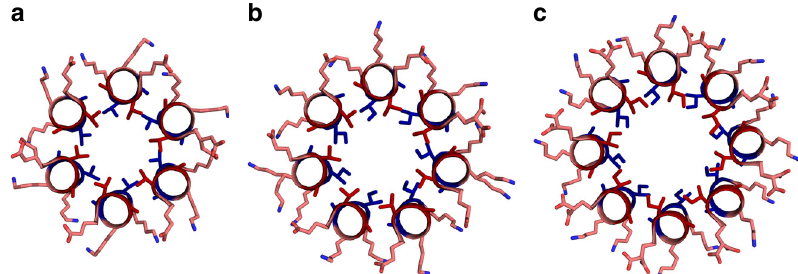
Fig. 5 α -Helical-barrel structures formed by the ββ class. a – c Single-heptad slices through structures for CC-Type2-VV ( a ), CC-Type2-IV ( b ), and CC- Type2-II ( c ). Val and Ile side chains are shown as sticks, and coloured blue and red to indicate perpendicular and parallel KIH packing, respectively